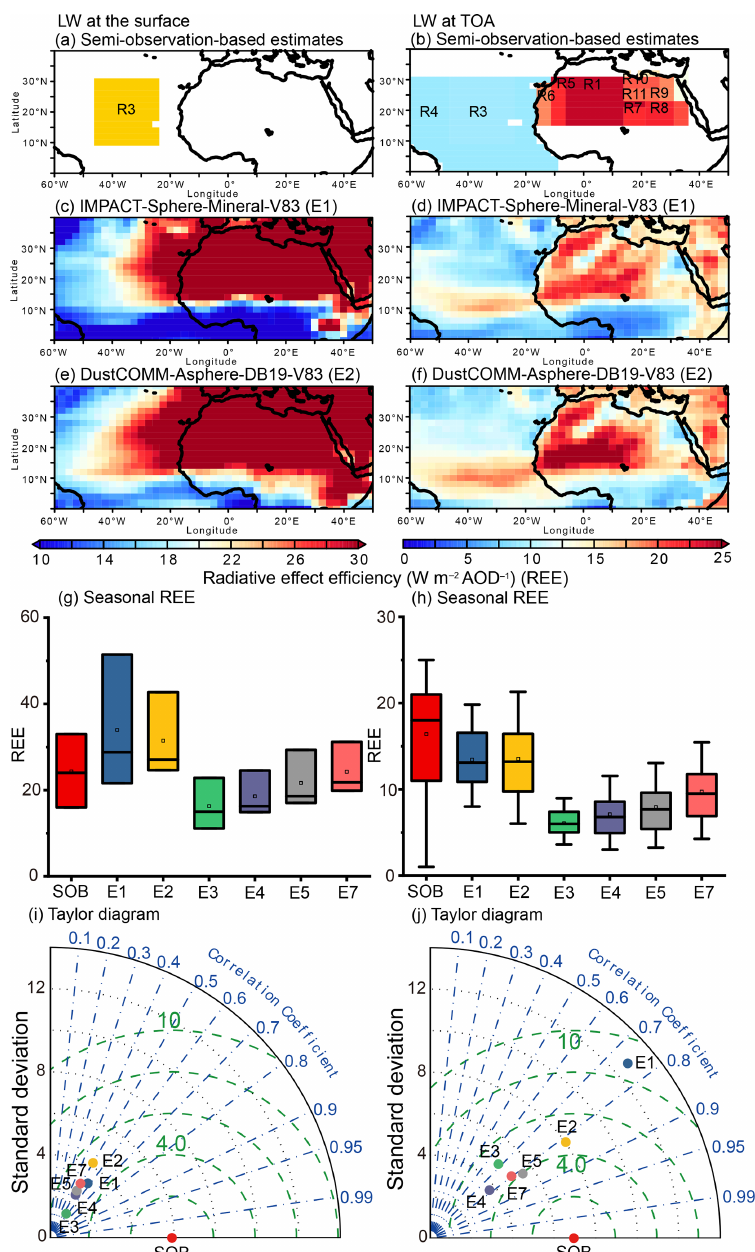
Figure 5. Dust clear-sky LW radiative effect efficiency (Wm − 2 DAOD − 1 ). Semi-observationally based estimates at (a) the surface and (b) TOA were based on satellite observations (Song et al., 2018; Christopher and Jones, 2007; Zhang and Christopher, 2003; Brindley and Russell, 2009; Yang et al., 2009). The model results are shown for (c, d) IMPACT-Sphere-Mineral-V83 (E1) and (e, f) DustCOMM- Asphere-DB19-V83 (E2) simulations at the surface and TOA, respectively. Comparison of seasonally averaged LW radiative effect efficiency for semi-observationally based (SOB) data and the different experiments at (g) the surface and (h) TOA. The square symbol represents the mean. The solid line within the box shows the median. The boundaries of the box mark the 25th and 75th percentiles. The whiskers above and below the box indicate the 1.5 × interquartile range, and the points indicate the outliers. Taylor diagram summarizing the statistics of the comparison against the seasonally averaged regional SW radiative effect efficiency for the different experiments at (i) the surface and (j) TOA. The horizontal axis shows the standard deviation of the data set or model prediction, the curved axis shows the correlation, and the green dashed lines denote the root-mean-squared errors between the semi-observationally based data and the model predictions. As such, the distance between the semi-observationally based data and the model predictions is a measure of the model’s ability to reproduce the spatiotemporal variability in the semi-observationally based data. The regionally averaged values are listed in Tables S5 and S6 at the surface and TOA,